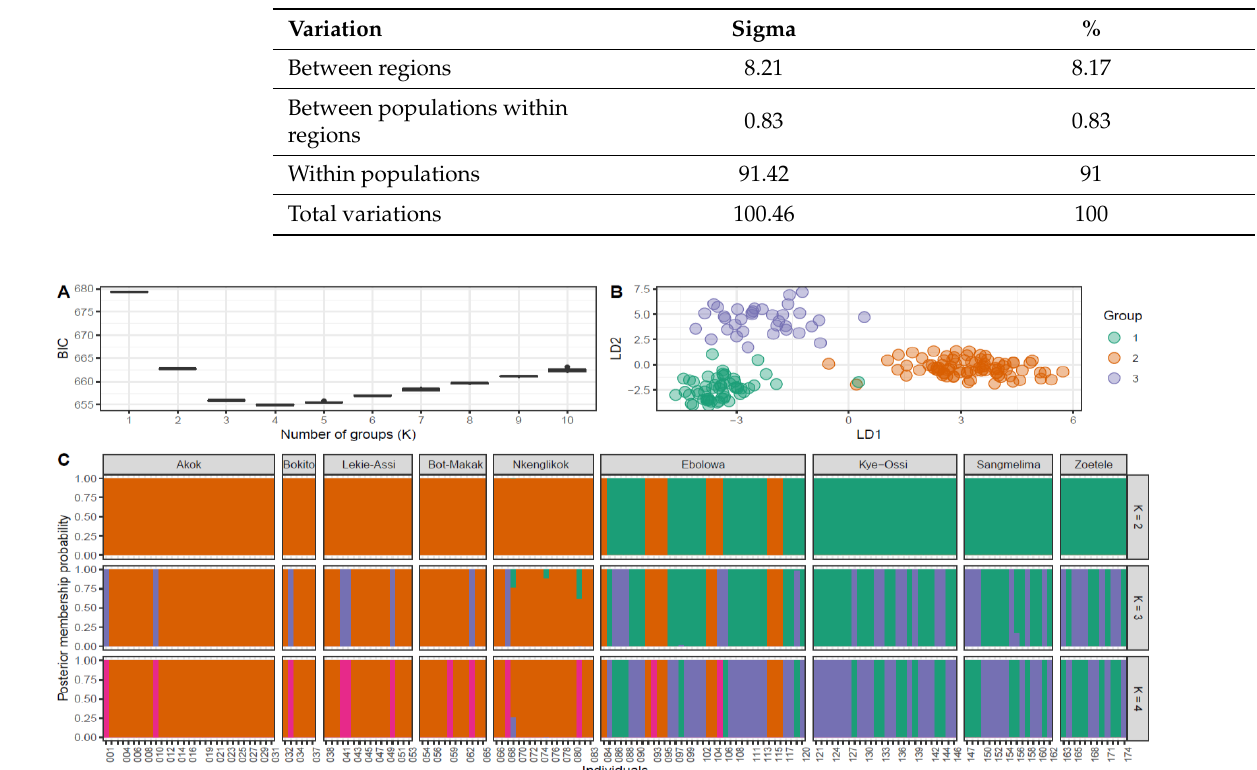
Table 7. Analysis of molecular variance.